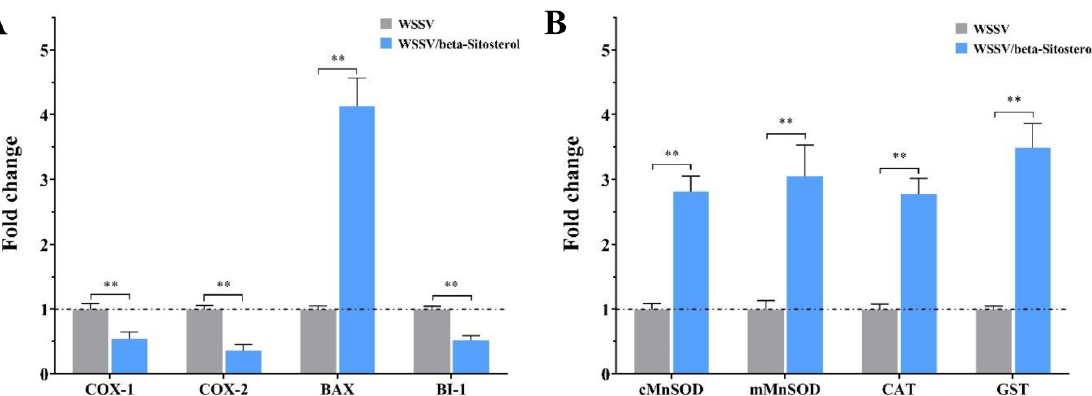
Figure 8. Beta-sitosterol regulated the expression of inflammatory-, apoptosis-, and antioxidant-re- lated factors in vivo (50 mg/kg, 24 hpi). ( A ) Inflammation- and apoptosis-related genes (COX-1, COX-2, Bax and BI-1). ( B ) Antioxidant-related genes (cMnSOD, mMnSOD, CAT, and GST). The 18S gene served as an internal reference. The data are shown as mean ± SD (n = 5). Asterisks indicate the significant difference between the experimental and control groups (** p <